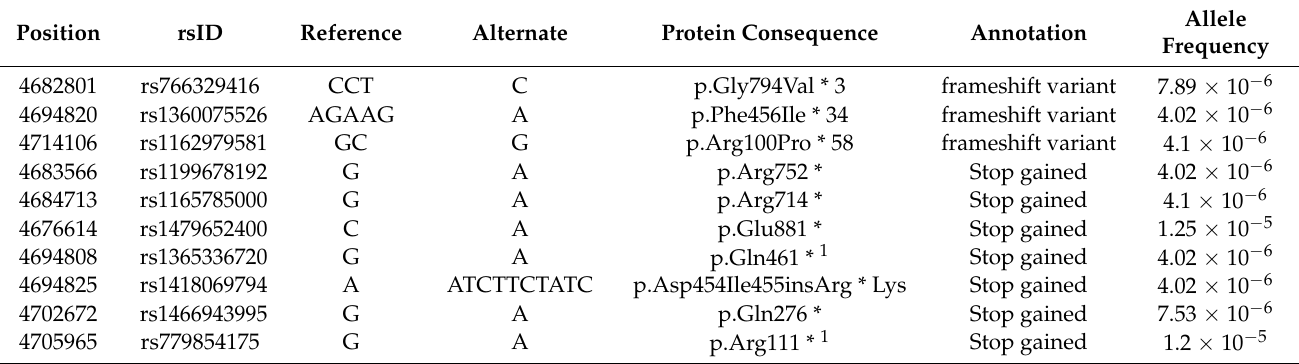
Table 3. DPP9 LoF variants from gnomAD. ins = insertion. * Premature termination codon (PTC).